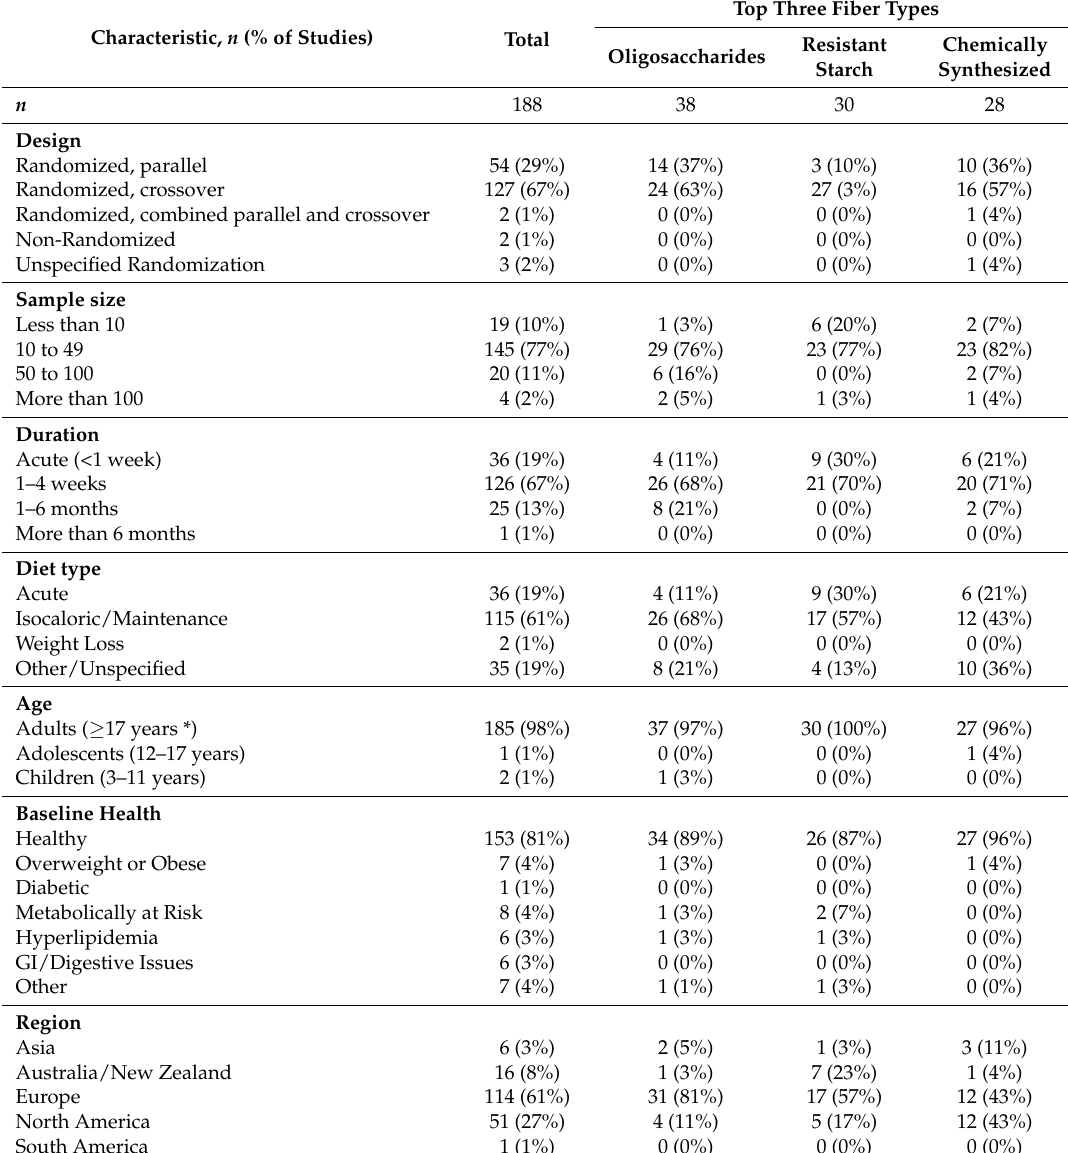
Table 1. Study Design